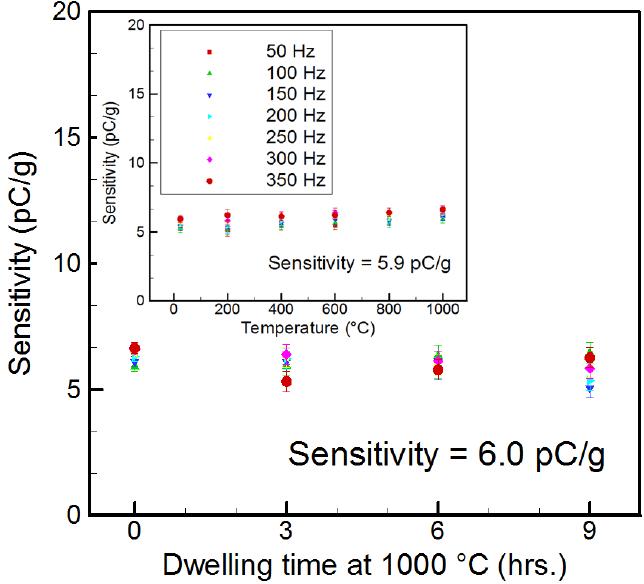
Figure 4. The measured sensitivity of the shear mode accelerometer with increasing temperature (25–1,000 °C) at the tested frequency range (50–350 Hz). The inset presents that the long-term sensitivity for the 9-hour dwell time test [58] (copyright 2012 by the